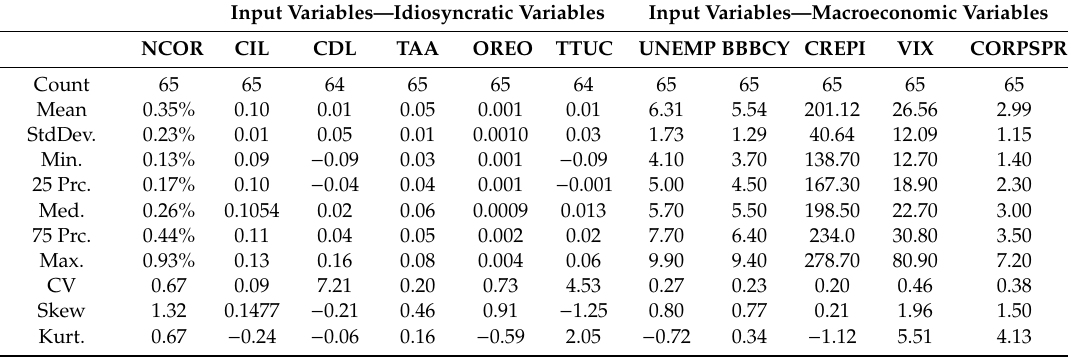
Table 1. Summary statistics of historical Y9 credit loss rates, banking system idiosyncratic variables, and macroeconomic variables (FDIC SDI Report and Federal Reserve Board 4Q91–4Q15).